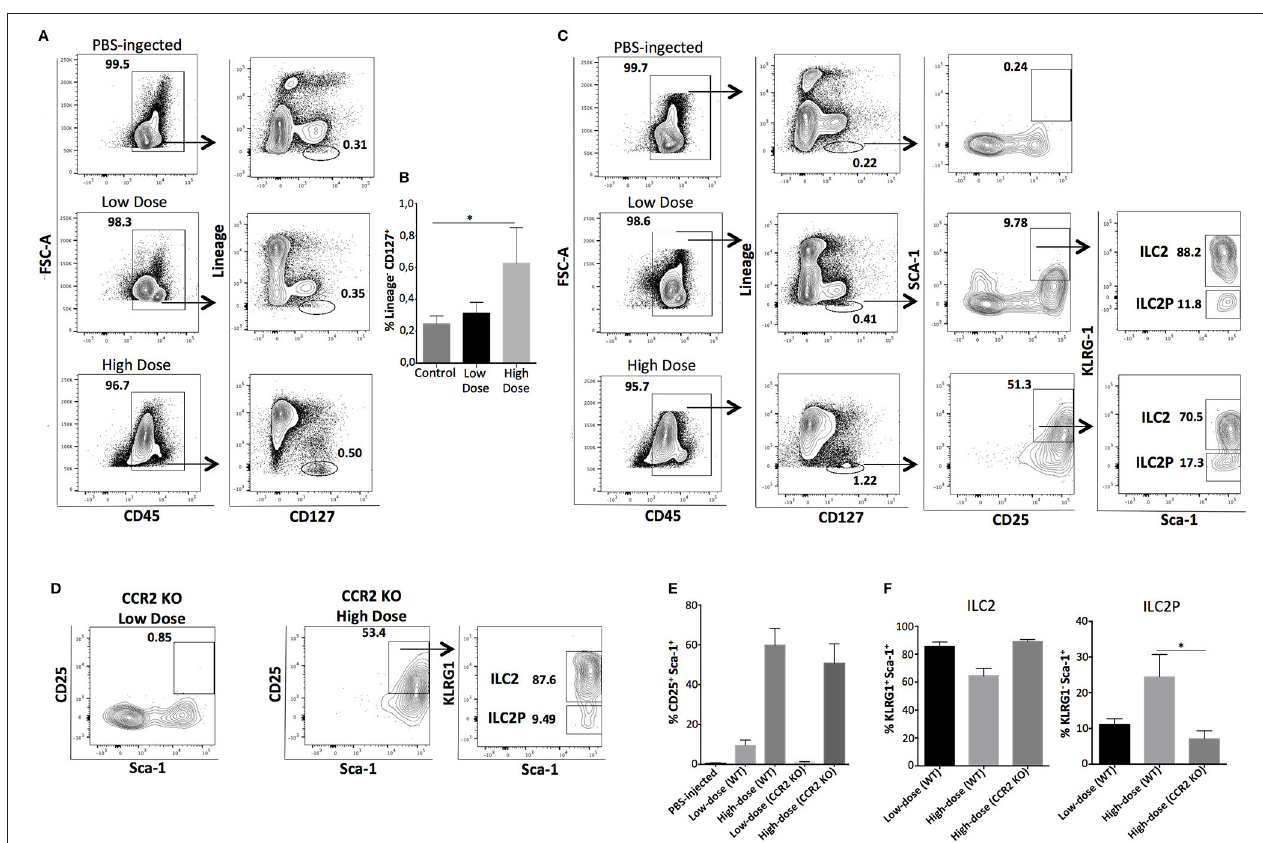
FIGURE 3 | ILCs and ILC2P cells emerge to the site of inflammation independently of HSPCs in response to high-dose of zymosan treatment. WT or CCR2 KO mice were injected with 0,1mg (low dose) or 10mg (high dose) of zymosan and 24h later peritoneal cells were harvested, stained for markers identifying both mature ILCs and progenitor cells of type 2 ILCs. (A) CCR2 KO mice where bone marrow-derived HSPCs are unable to migrate to the site of sterile inflammation, were injected either with a low- or high-dose of zymosan. Twenty-four hours post-injection, cells were recovered from the peritoneum of injected mice and stained for Lineage markers, CD45 and CD127. One representative experiment of flow cytometry analysis is shown from 4 independent experiments ( n = 4) (B) Statistical analysis of the frequency of Lineage − CD127 + cells recovered from the peritoneal cavity of zymosan-injected mice (CCR2 KO recipients). The same experimental process as described in (A) was used to investigate the emergence of bone marrow-derived progenitor cells for type 2 innate lymphoid cells in WT mice treated either with a low- or high-dose of zymosan. (C) Cells were stained for CD45, Lineage markers, CD127, CD25, Sca-1, and KLRG-1 ( n = 4). (D) Intraperitoneal cells were recovered from the peritoneal cavity of both high- and low-dose treated CCR2 KO mice and stained for markers of ILC2 and ILC2P as described in (B) . One representative experiment is shown ( n = 4). (E) Statistical analysis of the frequency of CD25 + Sca-1 + cells gated previously in CD45 + Lineage − CD127 + cells of both WT and CCR2 KO mice injected either with PBS (control) or low- and high-dose of zymosan ( n = 4). (F) Statistical analysis of the frequency of Sca-1 + KLRG1 + and Sca-1 + KLRG1 − cells from mice injected either with PBS or low- and high-dose zymosan both in WT and CCR2 KO mice ( n = 4). * p <